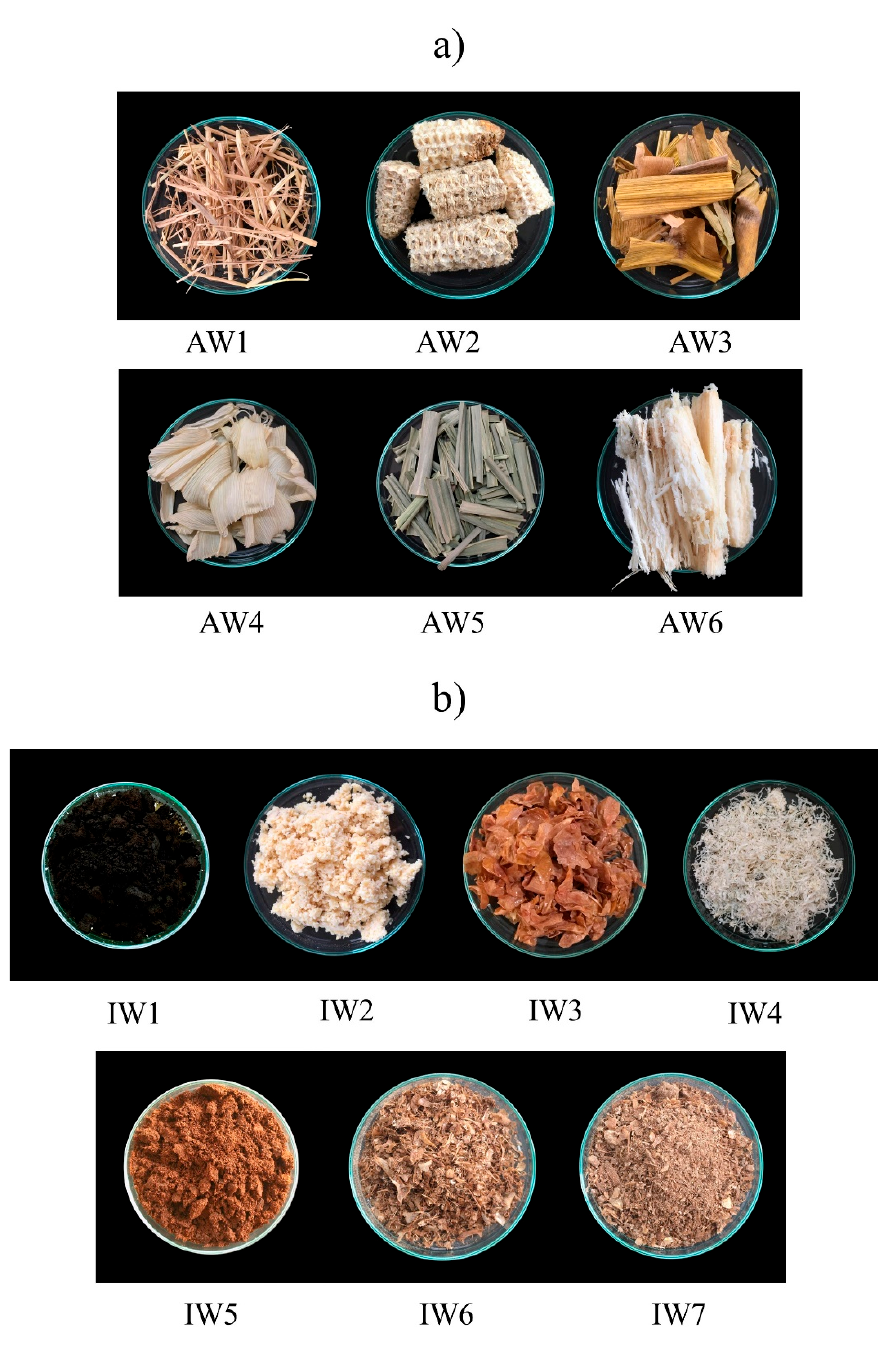
Figure 1. Images of the waste samples, by group: ( a ) agricultural wastes; ( b ) agro-industrial